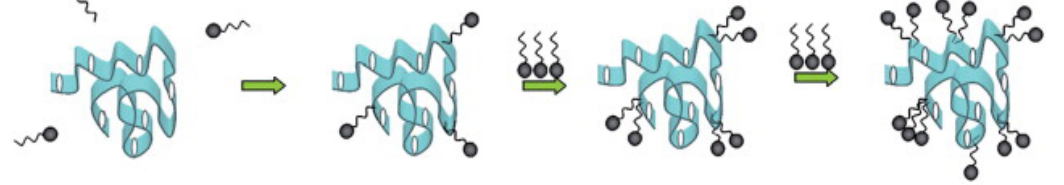
Figure 3. Schematic of interaction between protein molecules (e.g., enzyme) and non-ionic surfactants through hydrophobic interaction (Adopted from Maldonado-Valderramaa, and Rodríguez Patino,